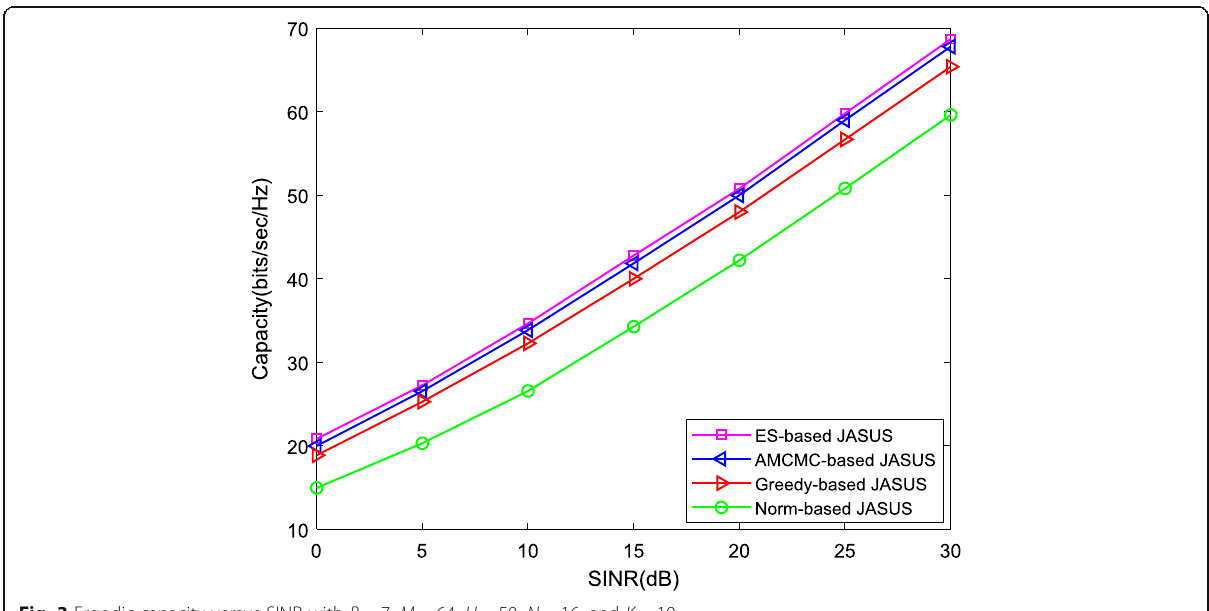
Fig. 3 Ergodic capacity versus SINR with B = 7, M = 64, U = 50, N = 16, and K = 10